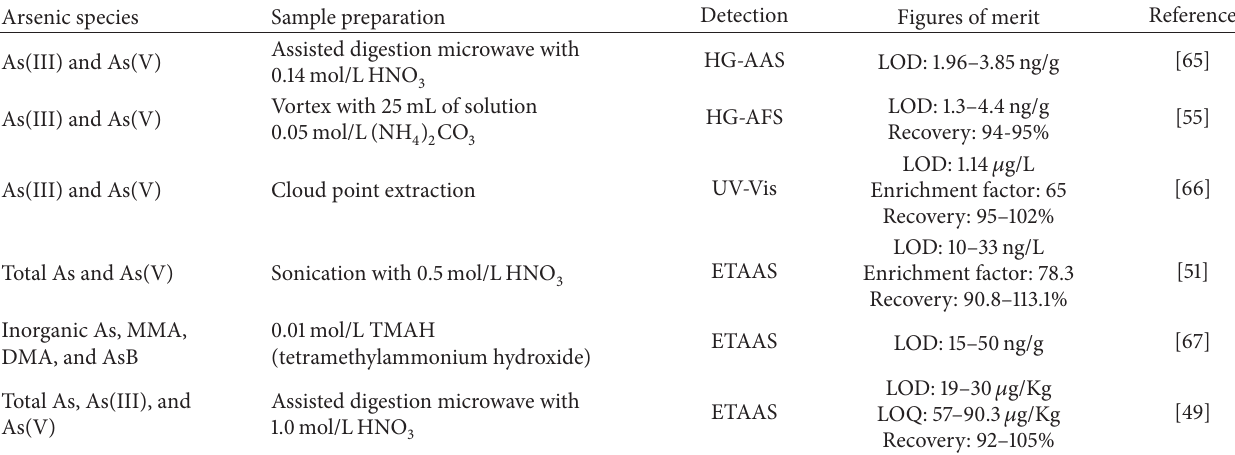
Table 3: Nonchromatographic methods for speciation of arsenic in